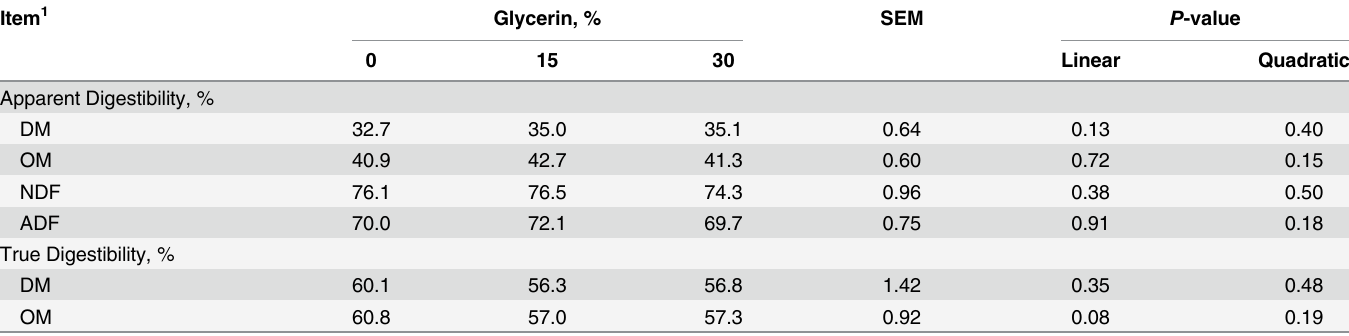
Table 2. Effect of glycerin inclusion on apparent and true digestibility of dietary nutrients in dual-flow continuous culture system. Item 1